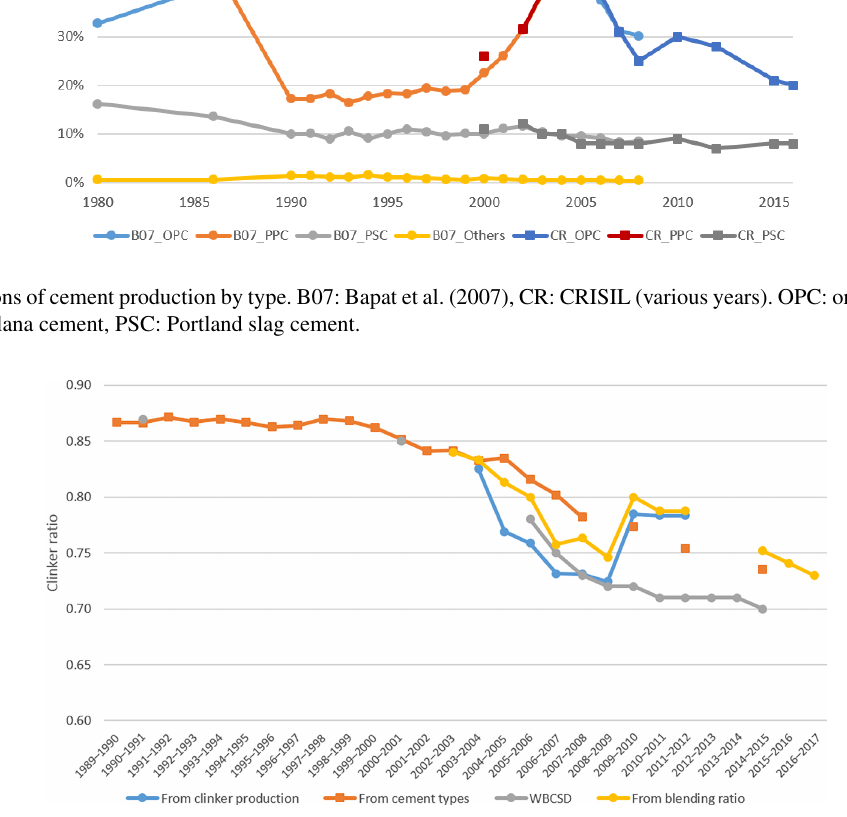
Figure D7. Estimates of clinker ratio in India from various